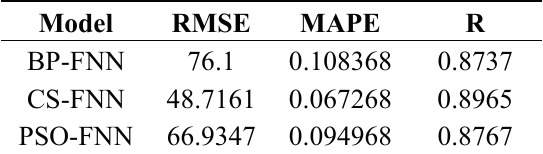
Table 3. Performance statistics of the models on testing dataset in the third scenario .